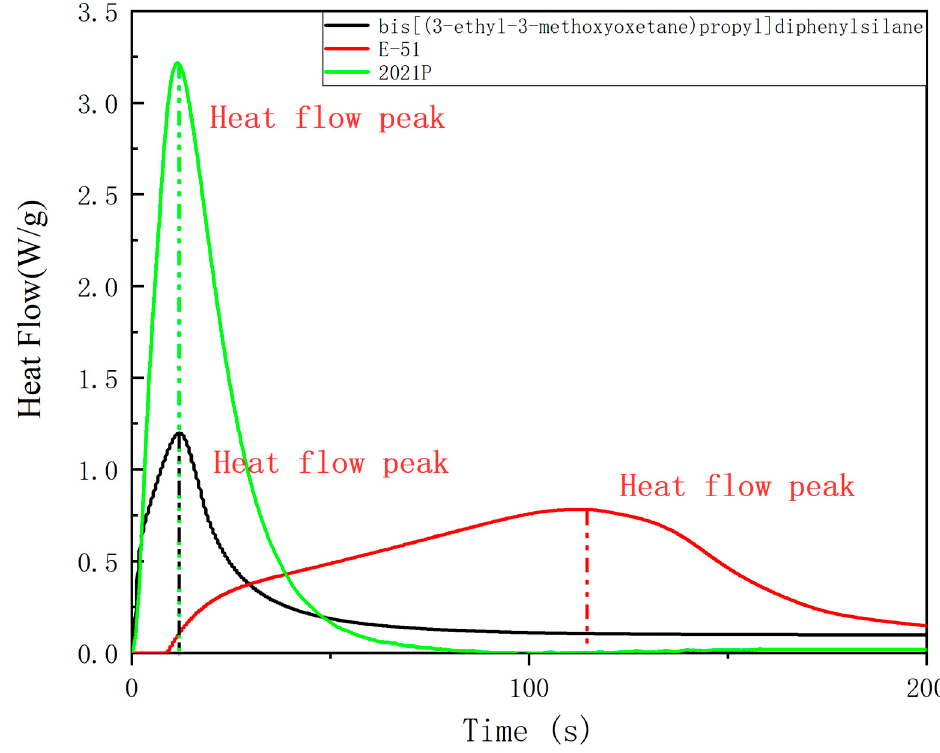
Figure 8. Heat flow of bis[(3-ethyl-3-methoxyoxetane)propyl]diphenylsilane,. E-51 and 2021 P.